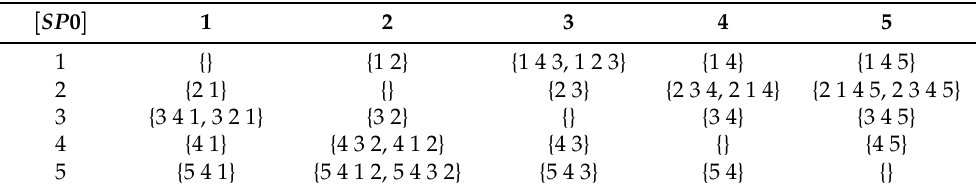
Table 4. Diameter limited paths for Figure